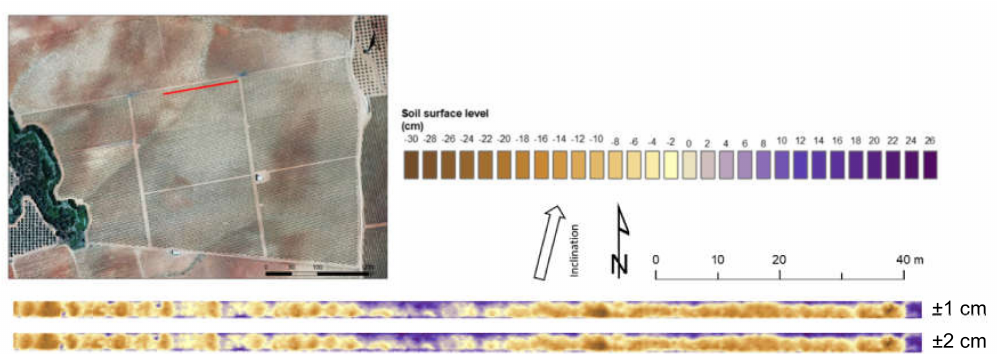
Figure 5. ISUM (Improve Stock Unearthing Method) map considering possible errors during the field measurement work from 1 to 2 cm.